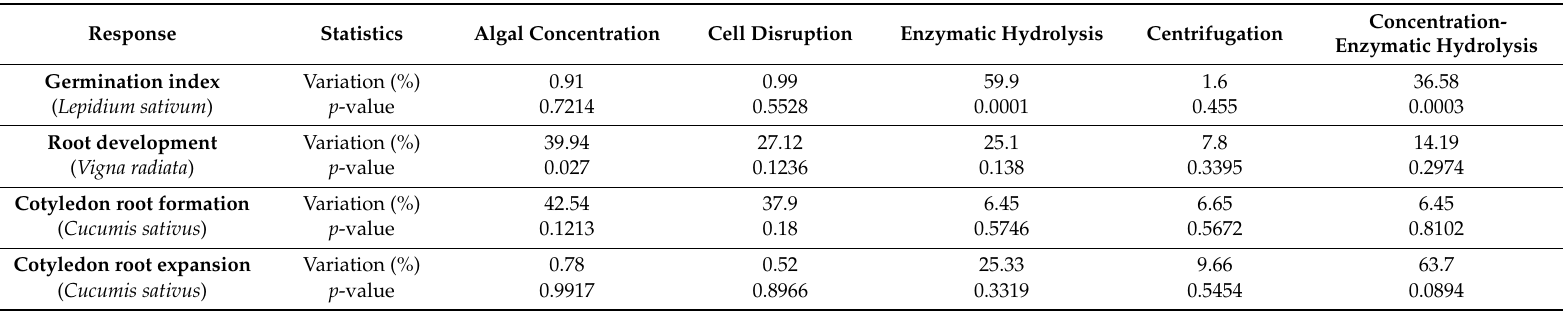
Table 2. Multifactor ANOVA testing the e ff ect of the microalgal extract concentration, the cell disruption, enzymatic hydrolysis and centrifugation on the germination index of the watercress seeds ( Lepidium sativum ), the presence of auxins (root development with Vigna radiata and cotyledon root development with Cucumis sativus ) and the presence of cytokinins (cotyledon root expansion with Cucumis sativus seeds; from Table 1 results). The data variability is attributable to the main e ff ect of each factor and the interaction found, as indicated by the p -value. The contribution of each factor was expressed as the percentage variation of the response (F ratio of each factor relative to the sum of all F-